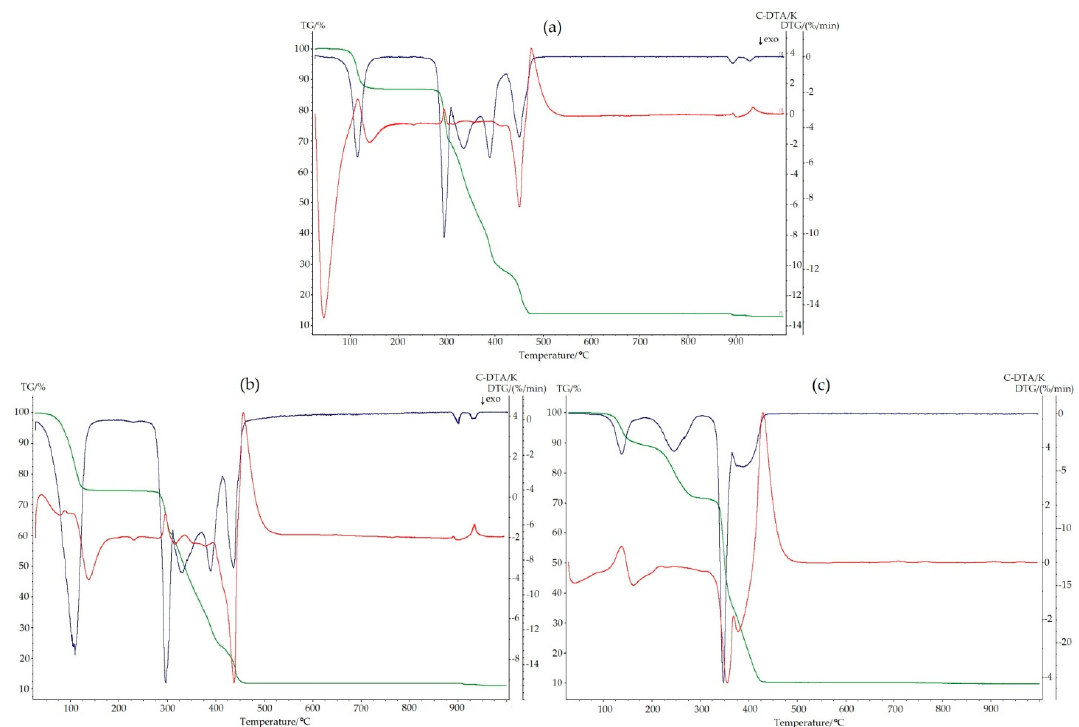
Figure 5. Thermoanalytical curves for 2 ( a ), 3 ( b ), and 4 ( c ). TG is plotted in green, DTG is in blue, while DTA is in red. while DTA is in